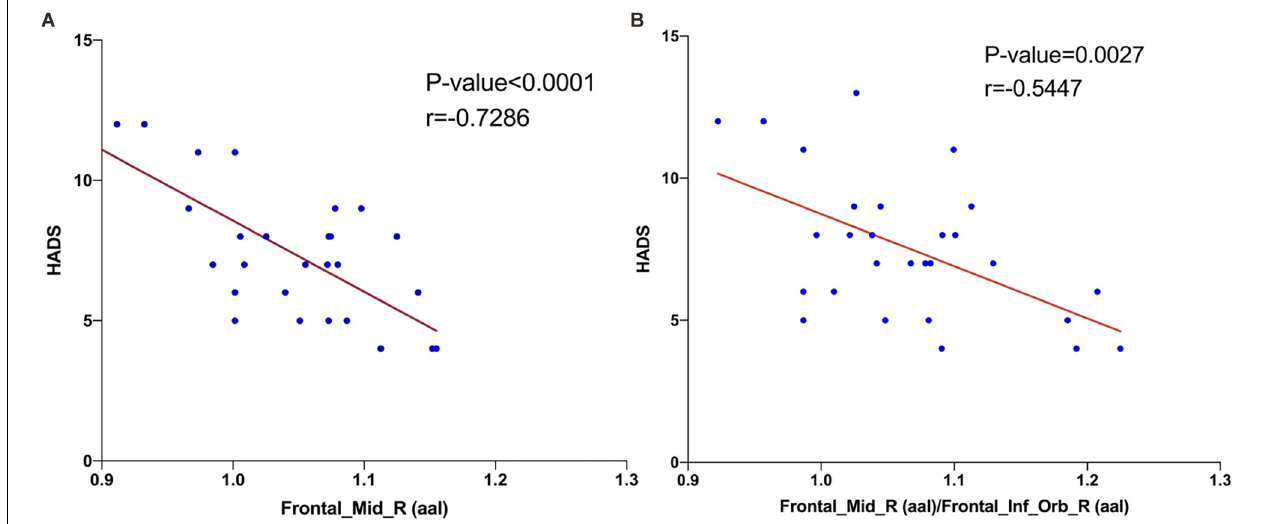
FIGURE 4 | Correlations between the HADS and ALFF values of brain area. The results shown in (A) and (B) both represent a negative correlation with the HADS and fALFF values in right middle frontal gyrus ( r = − 0.7286, P < 0.0001) and right middle frontal gyrus/right inferior frontal gyrus ( r = − 0.5447, P = 0.0027), respectively. Abbreviations: HADS, Hospital Anxiety and Depression Scale; fALFF, fractional amplitude of low-frequency fluctuation.